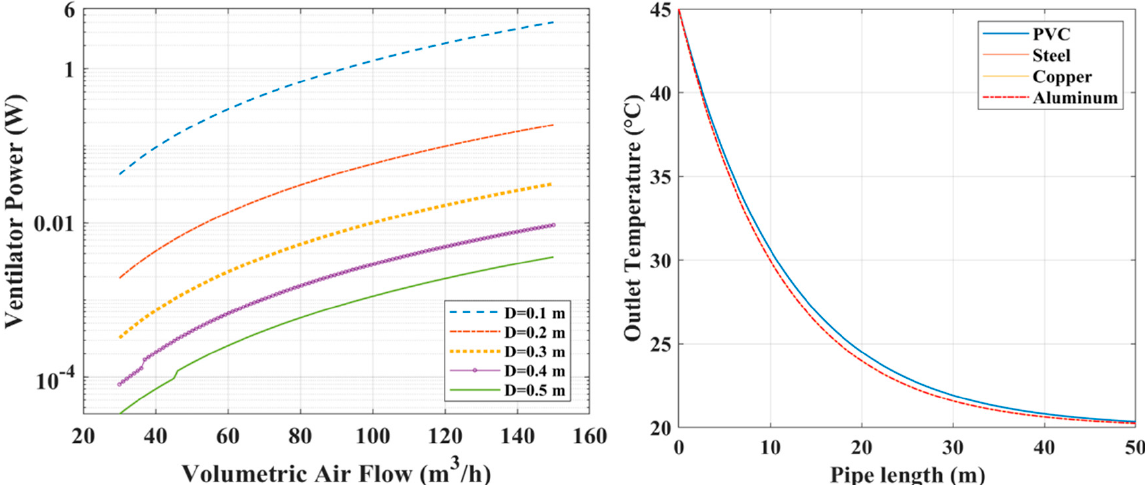
Figure 12. Ventilation power as a function of volumetric air flow rate for different pipe diameters and a length of 17 m (left) together with outlet air temperature as a function of pipe length for different pipe material (right).